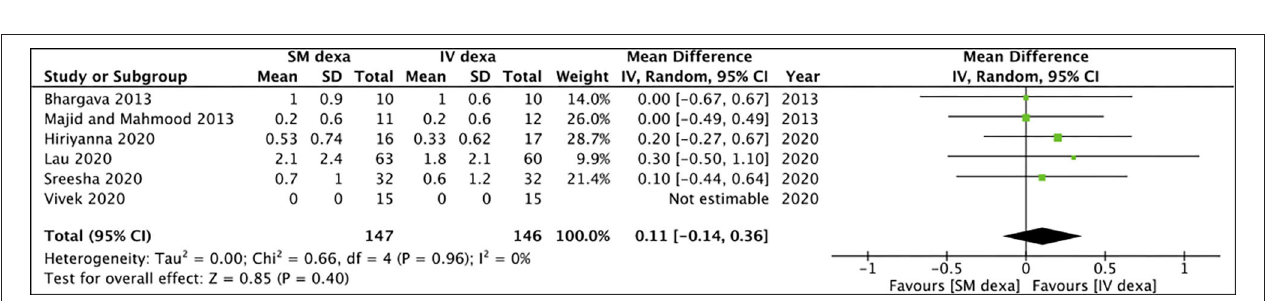
( Figure 8 ) as well as late pain scores (MD: − 0.25 95% CI: − 0.92 to 0.41 I 2 = 86% p = 0.45) ( Figure 9 ) between SM